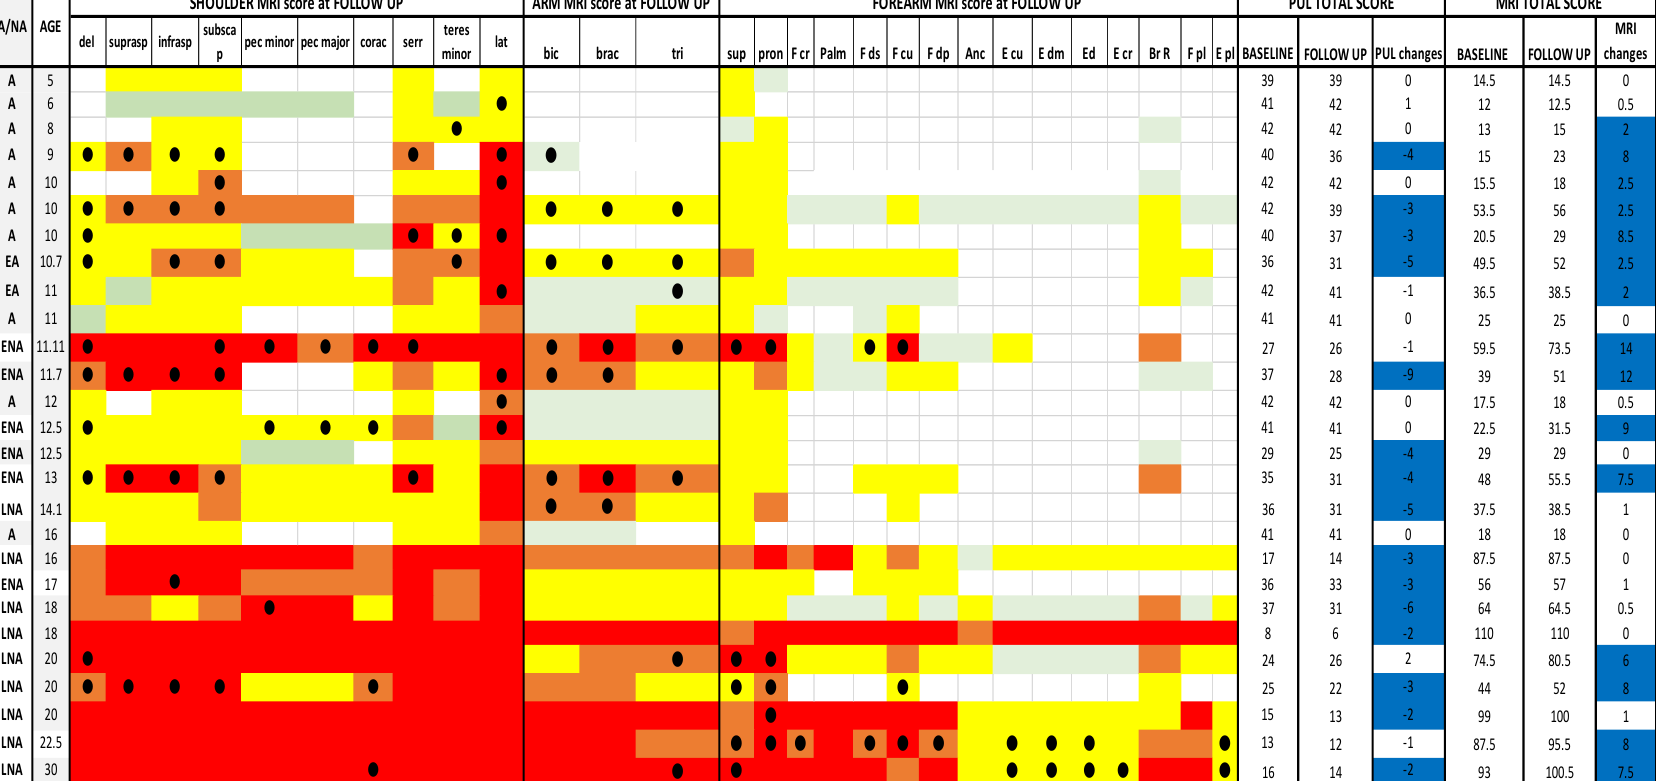
Figure 2. MRI and PUL scores at shoulder, arm and forearm level at baseline and at follow up. Individual details of imaging and PUL findings at shoulder, arm and forearm level. The shading reflects the severity of involvement with the score of 0 shown as a white cell, score of 1 as pale green, score of 2 as yellow, score of 3 as orange and score of 4 as red. Del = deltoid; suprasp = supraspinatus; infrasp = infraspinatus; subscap = subscapularis; pec = pectoralis; corac = coraco-brachialis; serr = serratus anterior; lat = latissimus dorsi; bic = biceps brachii; brac = brachialis; tri = triceps brachii; sup = supinator;pron = pronator teres; F cp = flexor carpi radialis; palm = palmar; F ds = flexor digitorum superficialis; F cu = flexor carpi ulnaris; Fdp = flexor digitorum profundus; Anc = anconeus; E cu = extensor carpi ulnaris; Edm = extensor digiti minimi; E d = extensor digitorum; E cr = extensor carpi radialis; Br R = brachioradialis; F pl = flexor pollicis longus; E pl = extensor pollicis longus. A= ambulant; EA = early ambulant; NA= non ambulant; ENA = early non ambulant; LNA: late non ambulant. ● Black circle means a higher Mercuri score respect to the baseline in the respective muscle. Blue line indicates changes in both MRI and PUL scores.